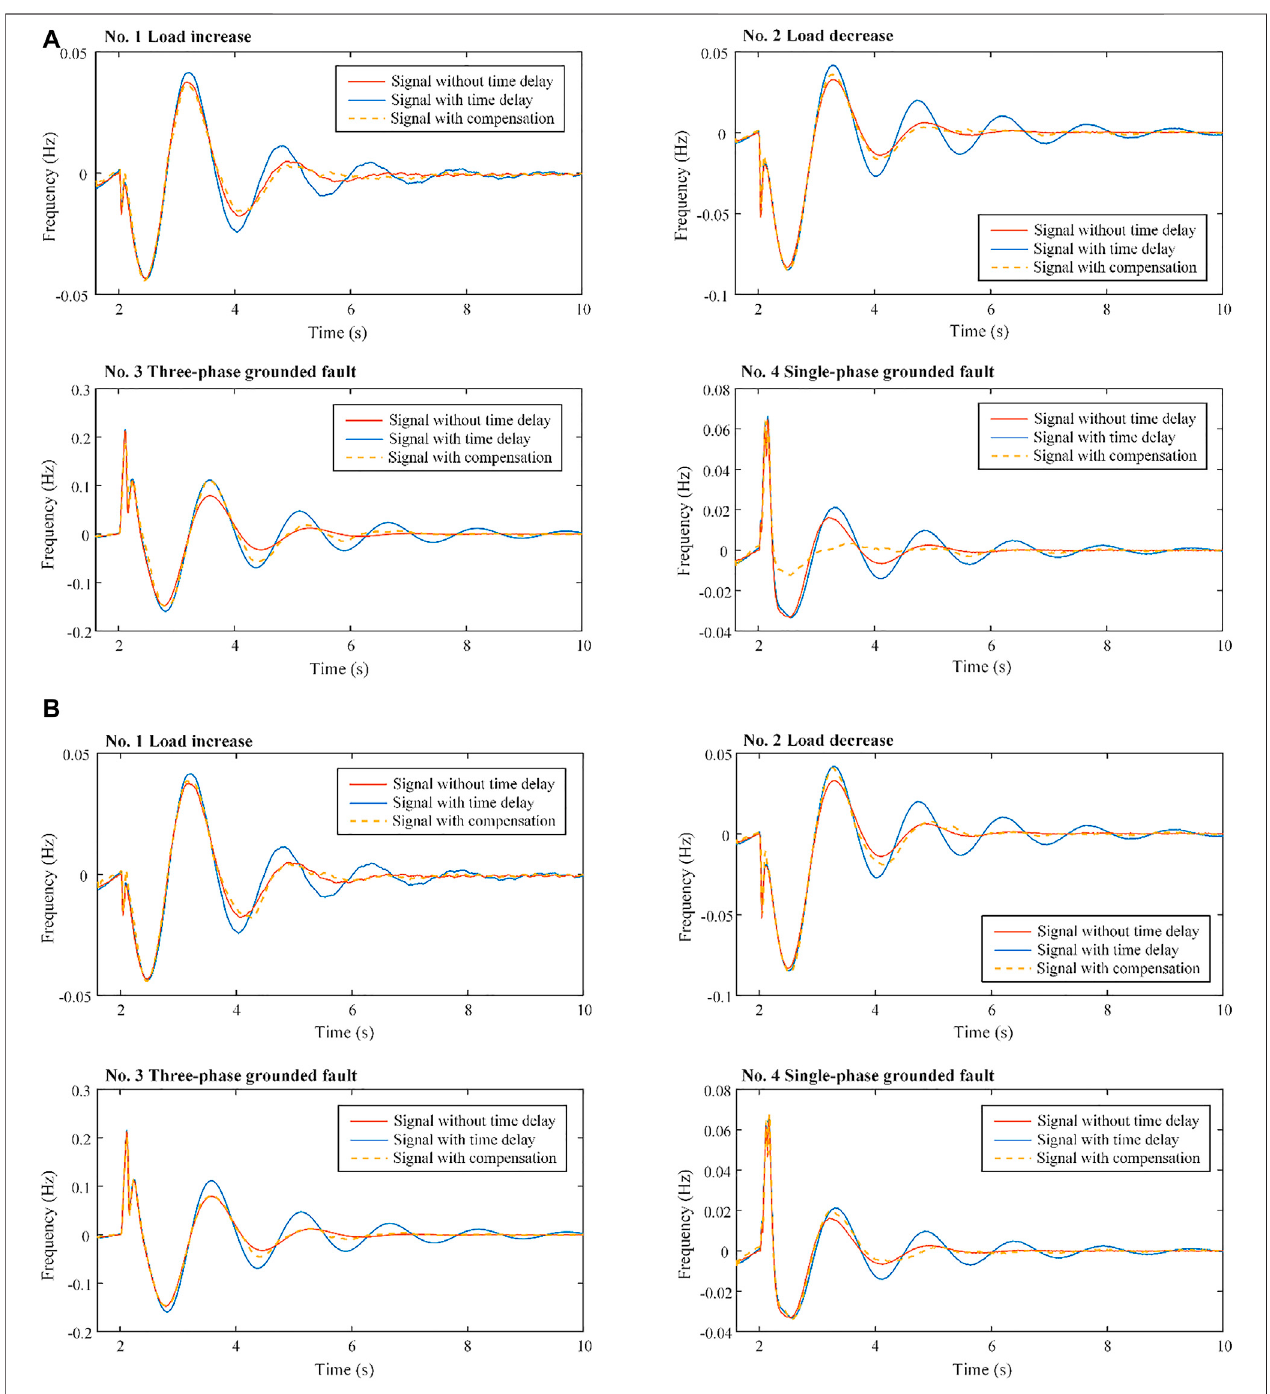
FIGURE 9 | Online validation results. (A) Scenario I. (B) Scenario